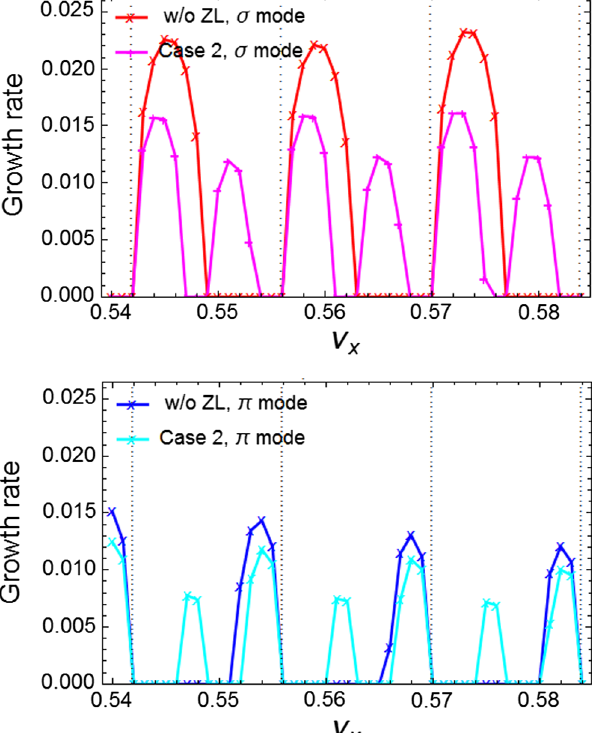
shift.FIG. 13. Comparison of growth rate between case 1 and case without longitudinal impedance for σ = π modes. In case 1, the trajectory is elliptical and we consider the incoherent synchrotron tune shift.